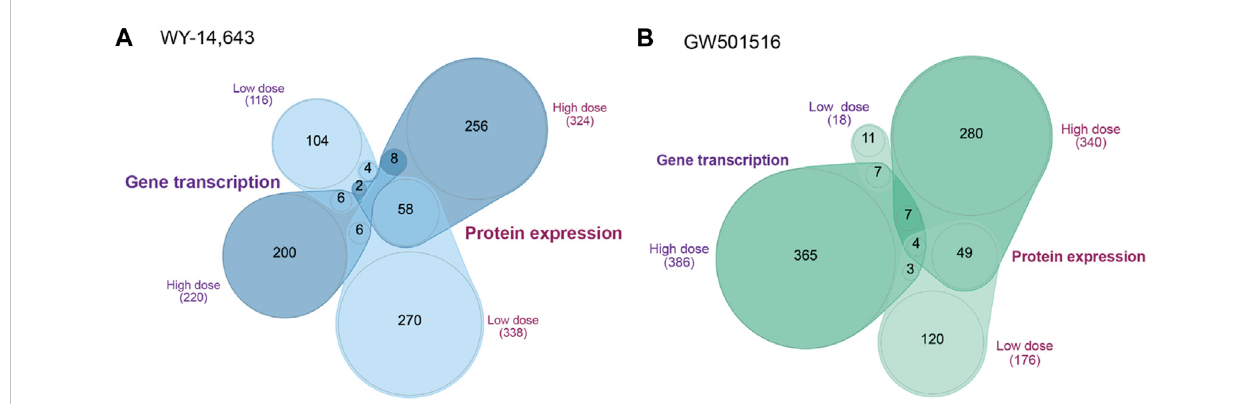
FIGURE 2 Quasi-proportional Venn diagram of shared differentially expressed genes and proteins in Atlantic cod liver following low and high dose of (A) WY- 14,643 and (B) GW501516. Venn diagram was drawn based on the annotated ENSEMBL gene ID, using the nVenn tool (Perez-Silva et al.,